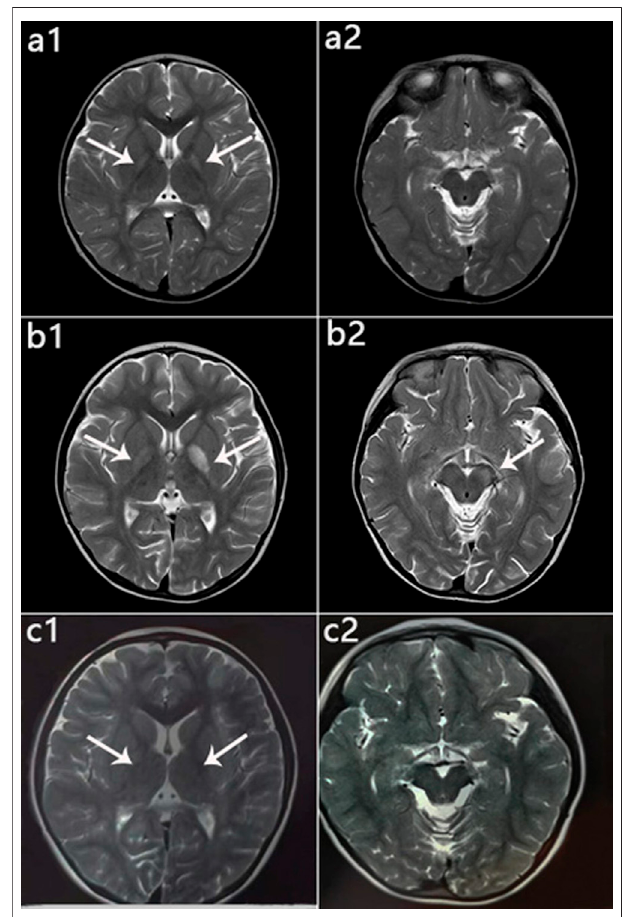
FIGURE 6 | Patient 1: MRI performance in the peak and recovery phases. (a1,a2) : Initial MRI obtained at age 2 years; hyperintensity on T2WI in the globus pallidus (a1) , normal cerebral peduncle (a2) . (b1,b2) : MRI performedat4 years5 monthsduringtheacutestage;hyperintensityon T2WI in the globus pallidus with swelling on the left side (b1) and in the left cerebralpeduncle (b2) . (c1,c2) :MRIperformedat6 years1 monthduringthe recoverystage;onlyslightlyhyperintensityonT2WIinglobuspallidus (c1) ,and Abnormal signal disappeared in the cerebral peduncle (c2) .